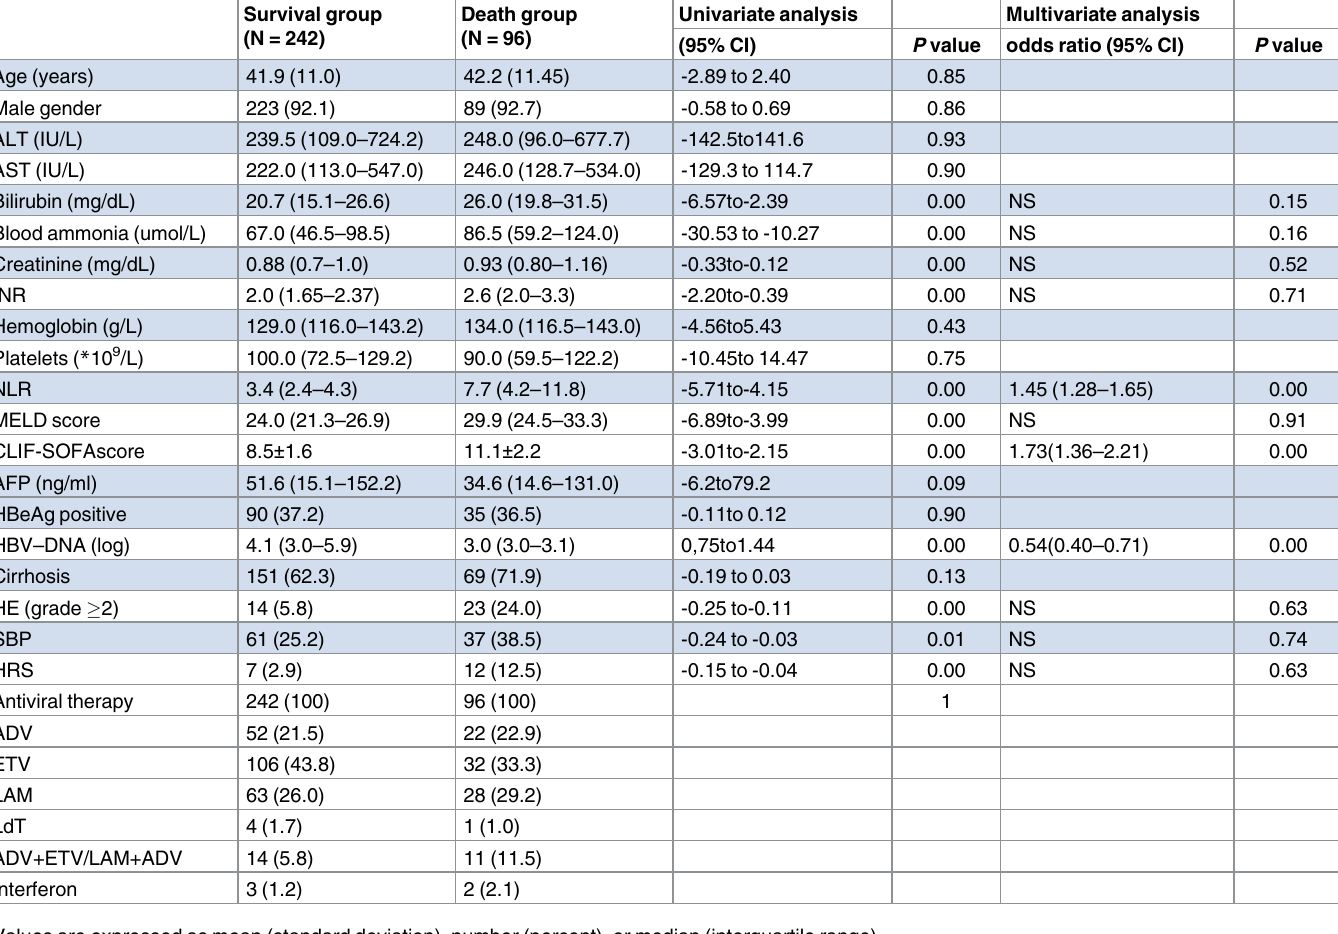
Table 3. Univariate and multivariate analysesof variables affecting 30-day mortality in the ALSS